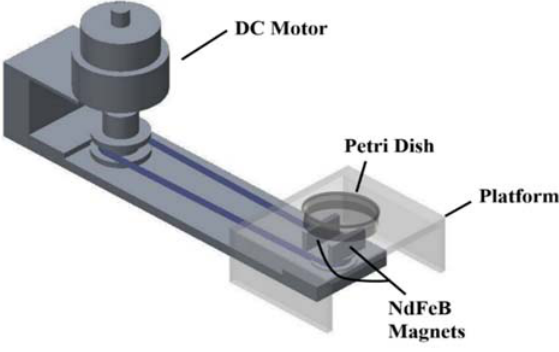
Figure 1. Schematic of the magnetic manipulation device.